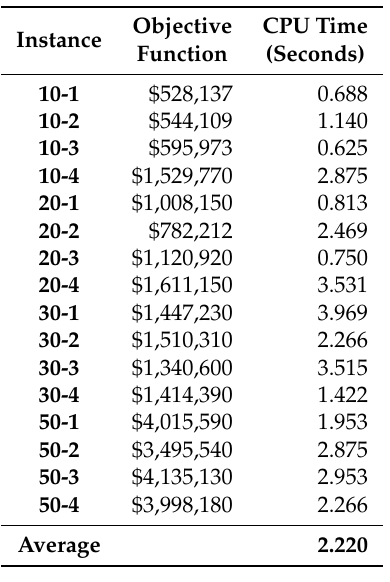
Table 7. Performance of the WS model over the test random